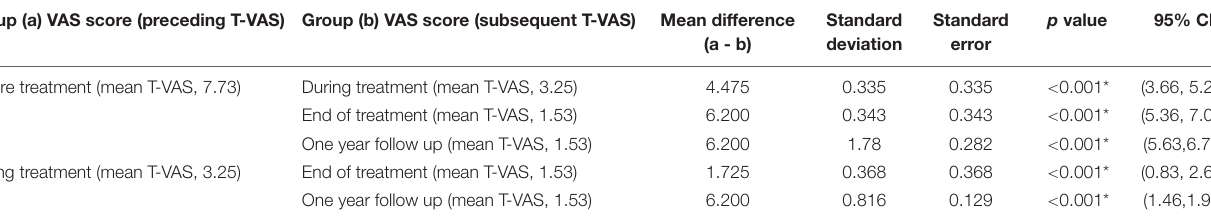
TABLE 4 | Results of the Dunnett T3 post hoc test regarding changes in the T-VAS score (tinnitus intensity) between different treatment time points: chronic tinnitus group. Group (a) VAS score (preceding T-VAS) Group (b) VAS score (subsequent T-VAS) Mean difference